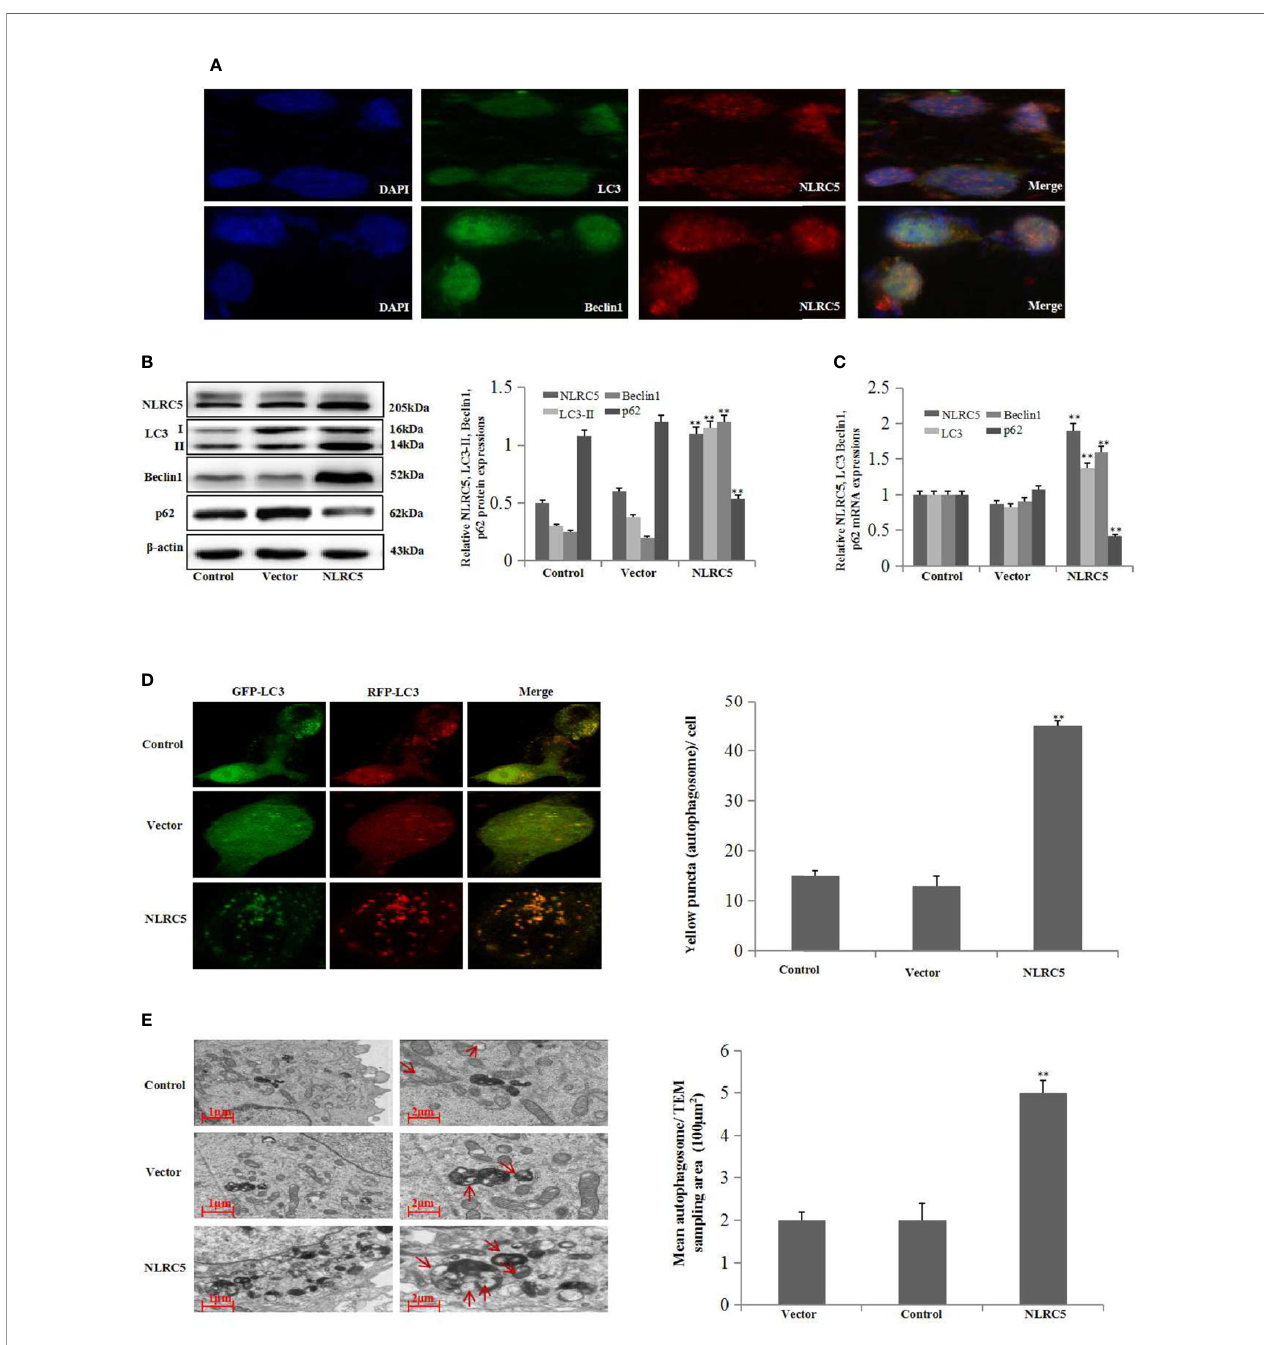
FIGURE 2 | Effect of NLRC5 over-expression on autophagy in EESCs (n = 7). (A) Representative image of immuno fl uorescence staining showing NLRC5 and LC3, Beclin1 are present both in the cytoplasm and nucleus, NLRC5 and LC3, Beclin1 were co-located in the nucleus. Photographs were taken at magni fi cations of 1600×. (B , C) Representative western blotting and qRT-PCR results showing over-expression of NLRC5 by transfection with NLRC5 plasmid signi fi cantly promoted NLRC5, LC3 Beclin1 expressions, and inhibited p62 expression when compared with vector group (**P < 0.01 vs. vector group). (D) Representative images showing LC3 staining in EESCs infected with GFP-RFP-LC3 adenovirus, over-expression of NLRC5 by transfection with NLRC5 plasmid signi fi cantly promoted yellow puncta when compared with vector group. Photographs were taken at magni fi cations of 1,600×, quanti fi cation of mean yellow puncta of 10 – 15 cells per condition is shown (**P < 0.01 vs. vector group). (E) Representative transmission electron microscopy (TEM) showing over-expression of NLRC5 by transfection with NLRC5 plasmid signi fi cantly promoted autophagosomes formation when compared with vector group, autophagosomes were highlighted by red arrows (left scale bar: 1 m m; right scale bar: 2 m m; **P < 0.01 vs. vector group). The expression levels of mRNA were normalized with respect to b -actin and were calculated using the 2 - DD Ct method. The protein expression levels were quanti fi ed by Image J software and normalized to b -actin protein levels. The results are represented as the mean ± SEM from at least three independent